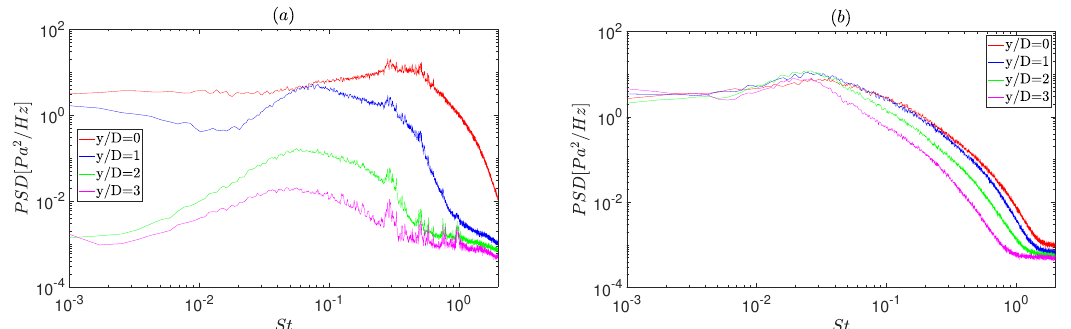
Figure 4. Span-wise evolution of the pressure autospectra for the jet–plate distance H/D = 0.75 and the jet Mach number M j = 0.5: ( a ) x/D = 5; ( b ) x/D =